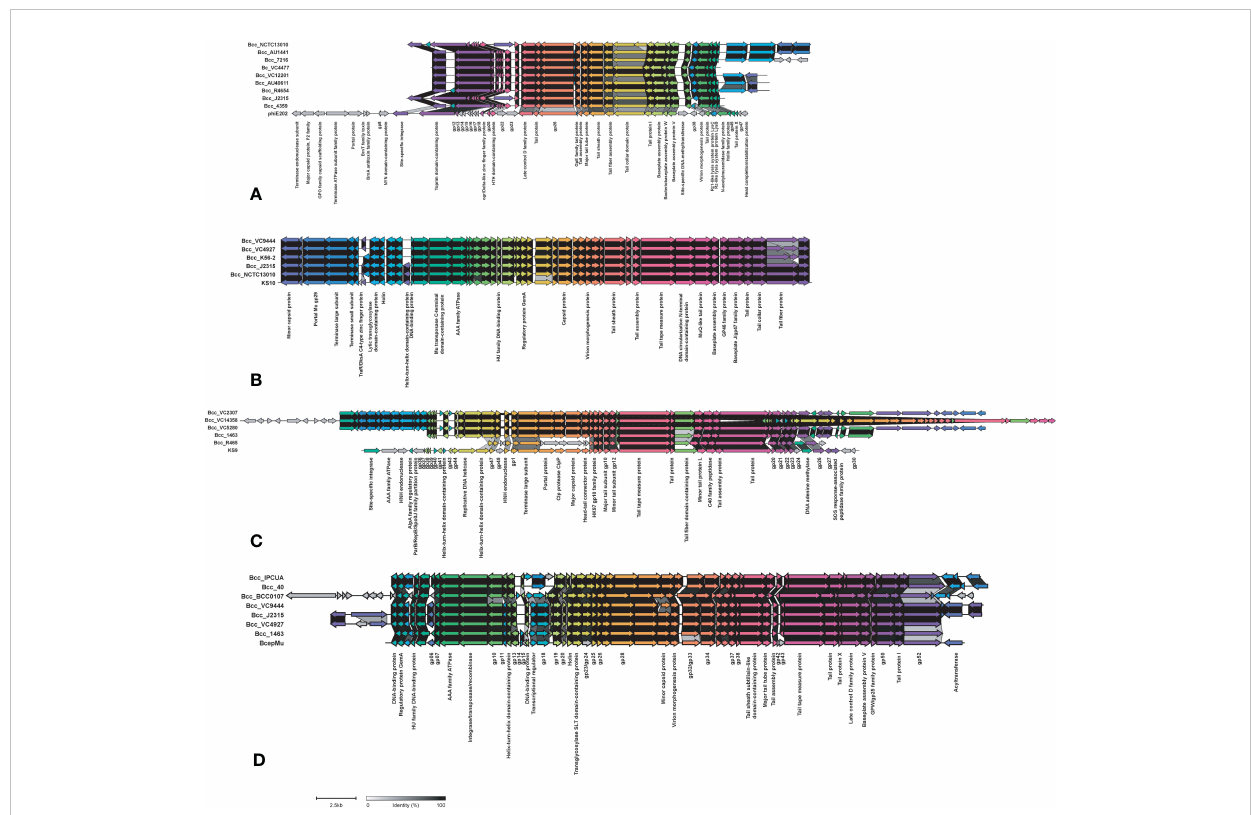
FIGURE 7 Comparison of phages phiE202 (A) , KS10 (B) , KS9 (C) , and BcepMu (D) between CC31 isolates across clades. The colored arrowed boxes and labels below boxes represent genes and gene product respectively. Connecting links between genes represent percent identity. The unlabeled arrows represent hypothetical